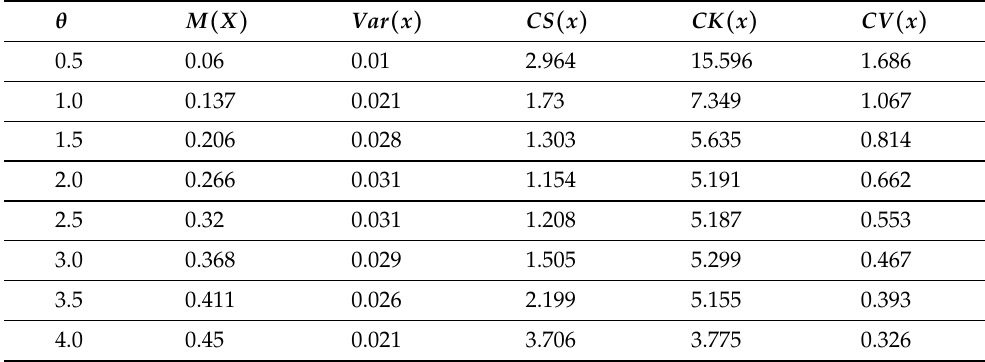
Table 3. Numerical values of M ( X ) , Var ( x ) , CS ( x ) , CK ( x ) , and CV ( x ) at β = α = 0.5 for the SBXLL